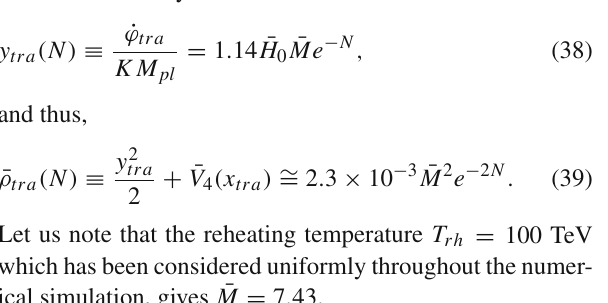
Fig. 5 Evolution of different energy densities has been shown, such as the matter sector (blue curve), radiation (red curve), tracker field (green curve) and the scalar field (black curve) in the logarithmic units. For the numerical simulation we consider γ = 1, reheating temperature T rh = 100 TeV and ¯ M = 0 . 0167. The initial conditions are taken at the matter-radiation